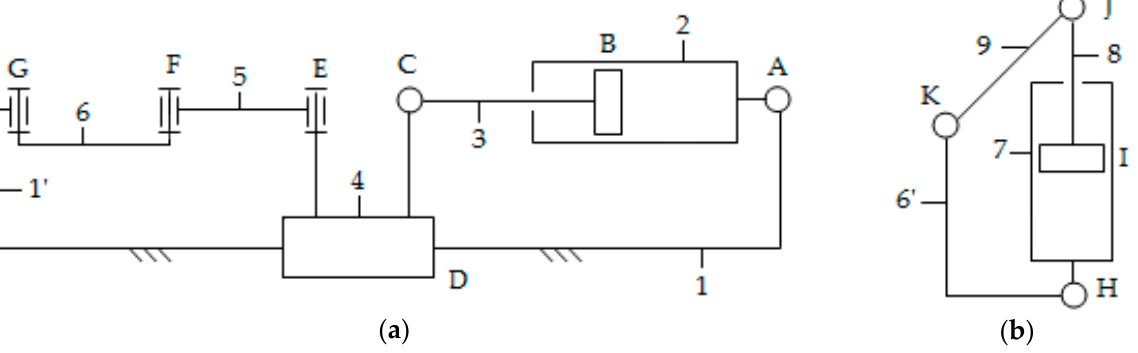
Figure 3. Structural scheme of the bi-axial tracking mechanism: ( a ) Azimuthal motion; ( b ) Altitudinal motion.